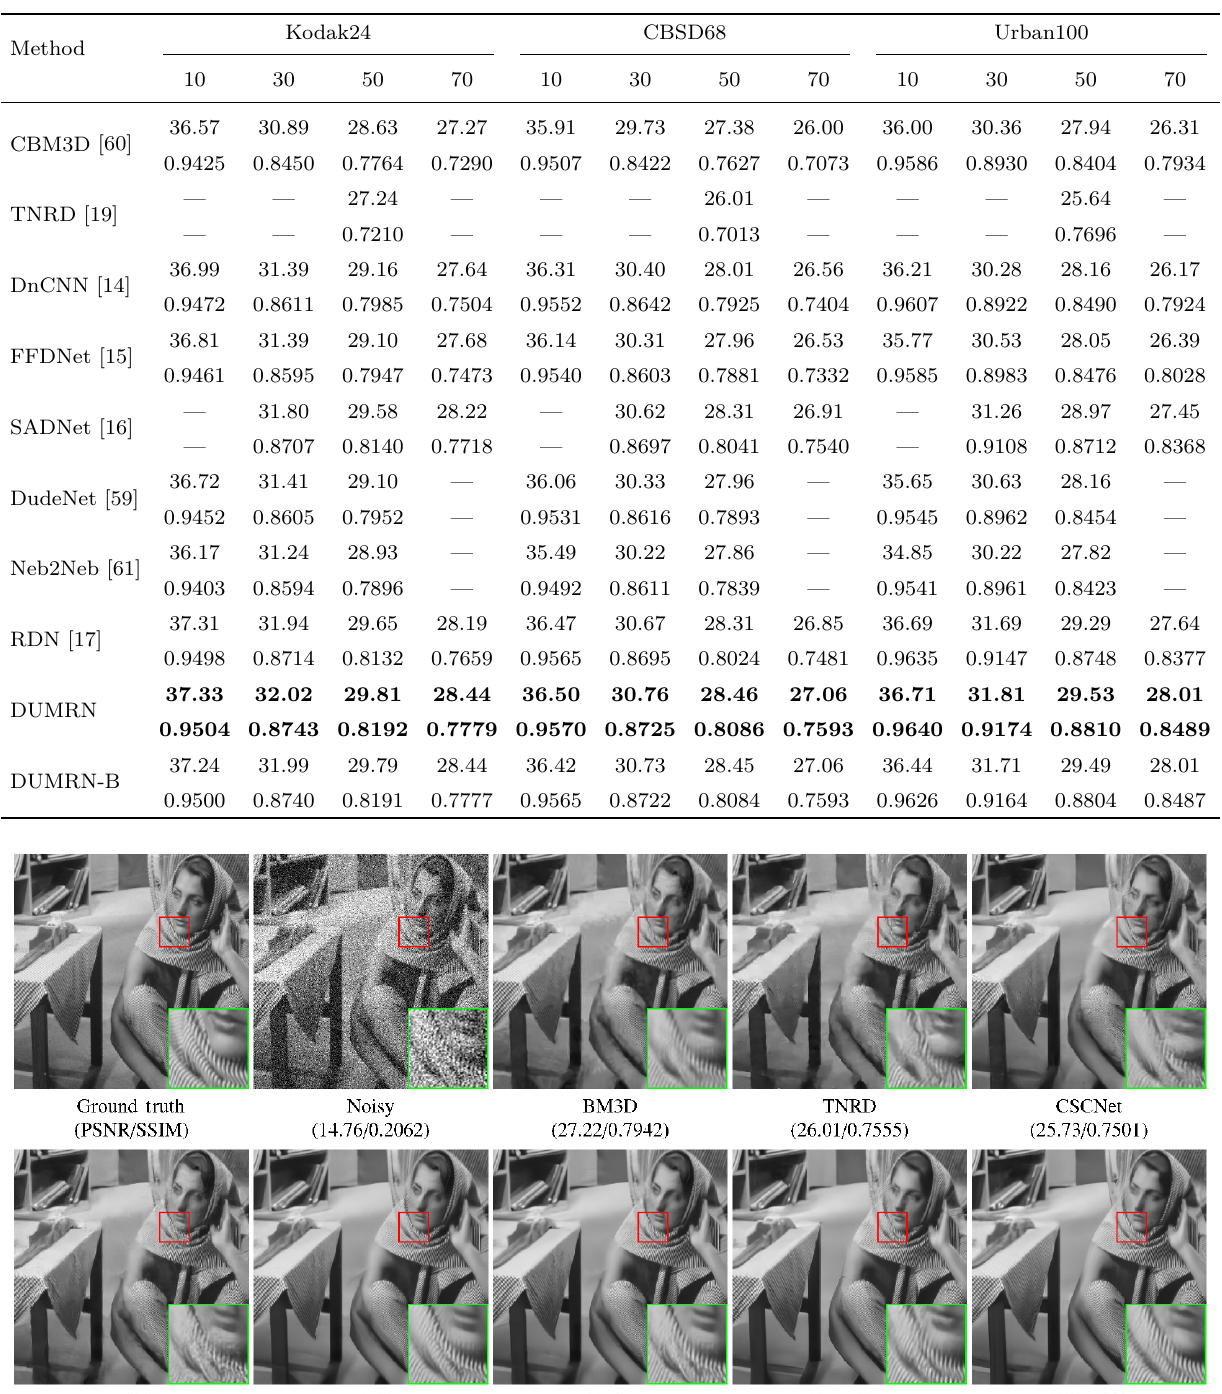
Table 2 Average PSNR (dB) and SSIM results for different methods on the color datasets for noise levels σ =10, 30, 50, and 70. Best results are highlighted in bold. “—” means the result is unavailable Method